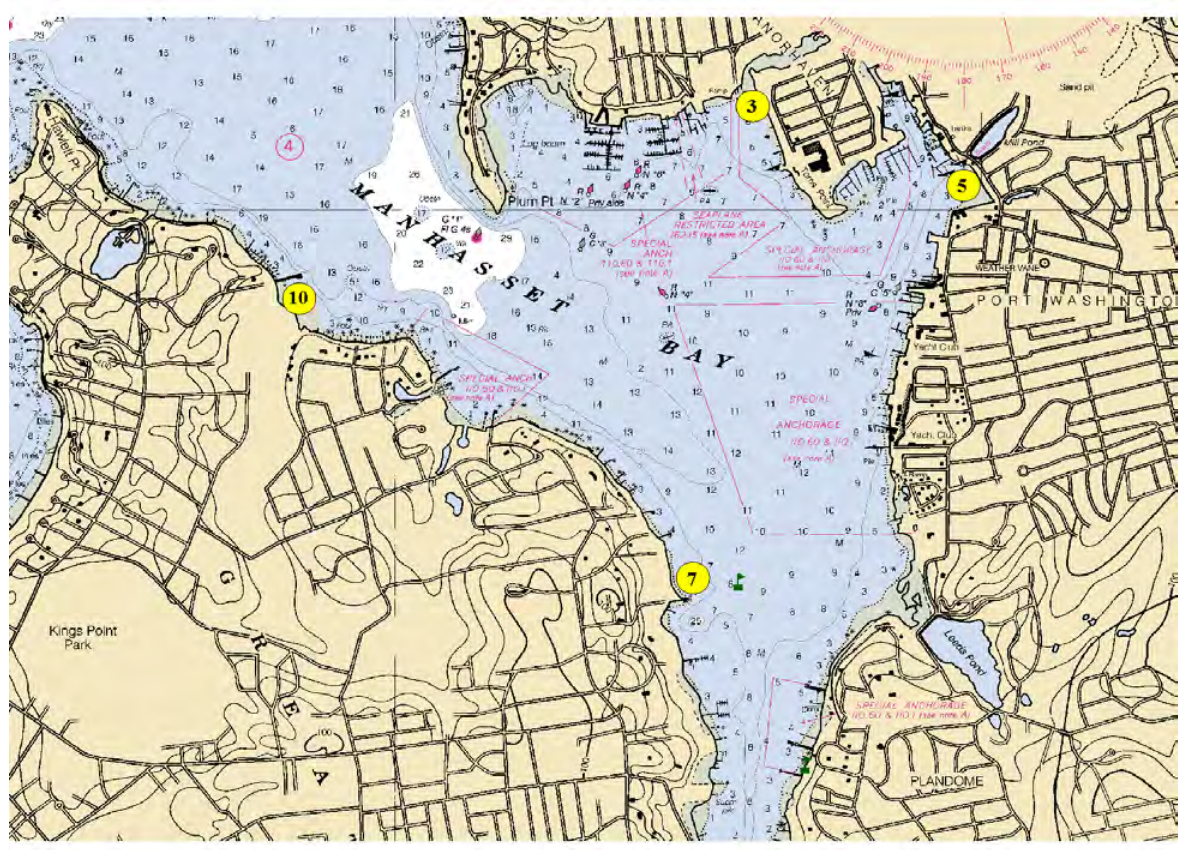
Figure 35. Map of New York DEC Western Long Island Beach Seine Survey Manhasset Bay